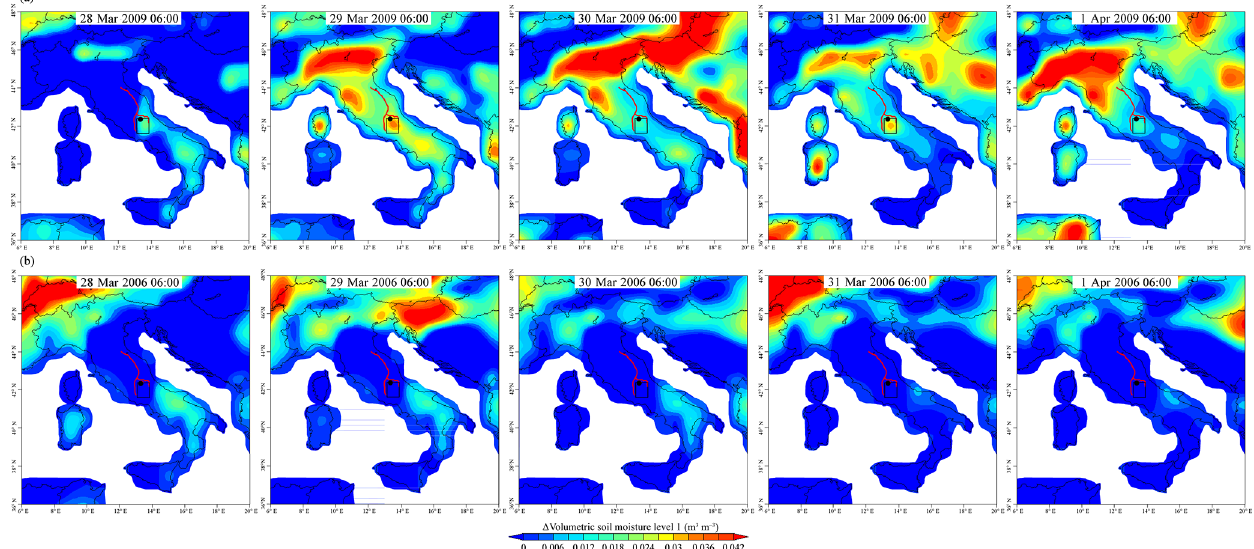
Figure 3. Spatial distributions of deviated volumetric soil moisture level 1 ( (cid:49) SML1) at 06:00UTC from 28 March to 1 April 2009 (a) and 2006 (b) , respectively. The black spot indicates the epicenter of the mainshock, the black rectangular box indicates the epicenter pixel, and the red line indicates the related main fault system.